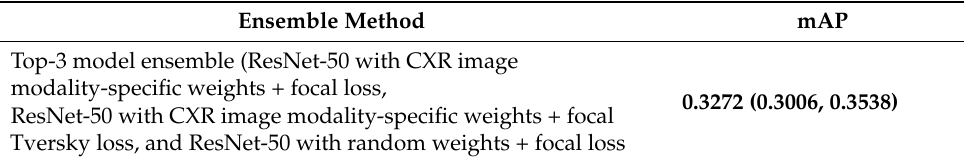
Figure 6. Bounding box predictions of the RetinaNet models initialized with varying weights for the classifier backbones. Green boxes denote the model predictions and red boxes denote the ground truth. ( a ) A sample CXR with ground truth bounding boxes. ( b ) ResNet-50 with CXR image modality-specific weights + focal Tversky loss; ( c ) ResNet-50 with CXR image modality-specific weights + focal loss, and ( d ) ResNet-50 with random weights + focal loss. Table 5. Ensemble performance with the top-3 performing models (from Table 4) and the top-3 snapshots for each of the models trained with various classifier backbones and weight initializa- tions. Values in parenthesis denote the 95% CI for the mAP metric. Bold numerical values denote superior